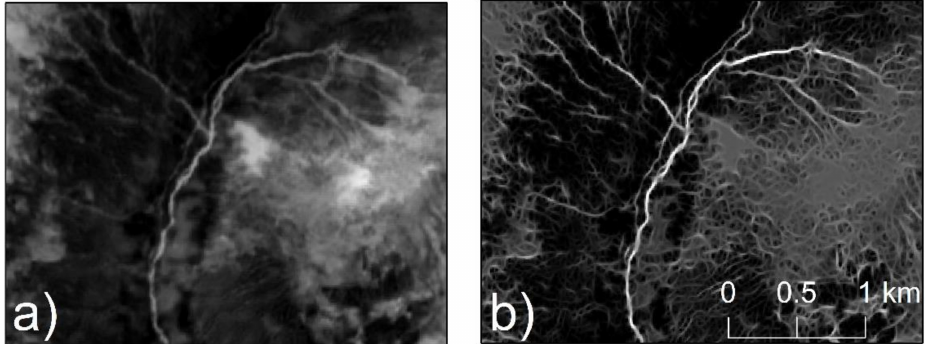
Figure 5. Performance of Gabor filtering. ( a ) MNDWI before filtering. ( b ) MNDWI after filtering.